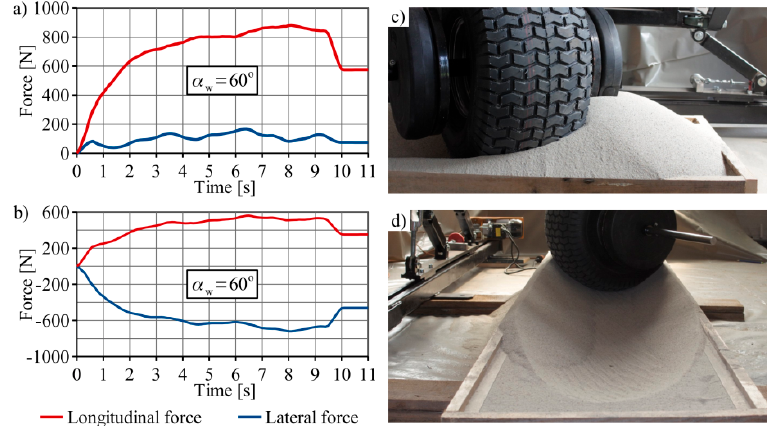
Figure 5. Graphs of the measured longitudinal and lateral forces relative to the direction of movement ( a ), as well as the calculated longitudinal and lateral forces relative to the geometry of the wheel ( b ), for α w = 60°. The wheel on the experimental stand after the test ( c ), and the resulting tire track ( d ) [21].